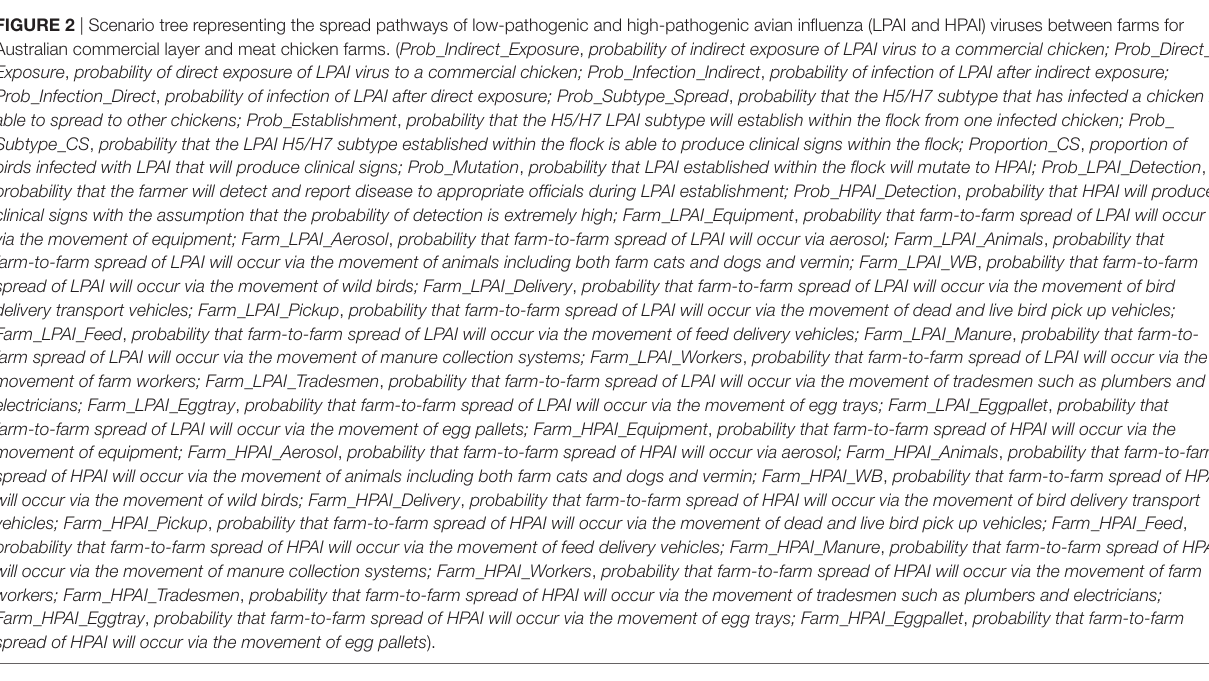
FigUre 2 | Scenario tree representing the spread pathways of low-pathogenic and high-pathogenic avian influenza (LPAI and HPAI) viruses between farms for Australian commercial layer and meat chicken farms. ( Prob_Indirect_Exposure , probability of indirect exposure of LPAI virus to a commercial chicken; Prob_Direct_ Exposure , probability of direct exposure of LPAI virus to a commercial chicken; Prob_Infection_Indirect , probability of infection of LPAI after indirect exposure; Prob_Infection_Direct , probability of infection of LPAI after direct exposure; Prob_Subtype_Spread , probability that the H5/H7 subtype that has infected a chicken is able to spread to other chickens; Prob_Establishment , probability that the H5/H7 LPAI subtype will establish within the flock from one infected chicken; Prob_ Subtype_CS , probability that the LPAI H5/H7 subtype established within the flock is able to produce clinical signs within the flock; Proportion_CS , proportion of birds infected with LPAI that will produce clinical signs; Prob_Mutation , probability that LPAI established within the flock will mutate to HPAI; Prob_LPAI_Detection , probability that the farmer will detect and report disease to appropriate officials during LPAI establishment; Prob_HPAI_Detection , probability that HPAI will produce clinical signs with the assumption that the probability of detection is extremely high; Farm_LPAI_Equipment , probability that farm-to-farm spread of LPAI will occur via the movement of equipment; Farm_LPAI_Aerosol , probability that farm-to-farm spread of LPAI will occur via aerosol; Farm_LPAI_Animals , probability that farm-to-farm spread of LPAI will occur via the movement of animals including both farm cats and dogs and vermin; Farm_LPAI_WB , probability that farm-to-farm spread of LPAI will occur via the movement of wild birds; Farm_LPAI_Delivery , probability that farm-to-farm spread of LPAI will occur via the movement of bird delivery transport vehicles; Farm_LPAI_Pickup , probability that farm-to-farm spread of LPAI will occur via the movement of dead and live bird pick up vehicles; Farm_LPAI_Feed , probability that farm-to-farm spread of LPAI will occur via the movement of feed delivery vehicles; Farm_LPAI_Manure , probability that farm-to- farm spread of LPAI will occur via the movement of manure collection systems; Farm_LPAI_Workers , probability that farm-to-farm spread of LPAI will occur via the movement of farm workers; Farm_LPAI_Tradesmen , probability that farm-to-farm spread of LPAI will occur via the movement of tradesmen such as plumbers and electricians; Farm_LPAI_Eggtray , probability that farm-to-farm spread of LPAI will occur via the movement of egg trays; Farm_LPAI_Eggpallet , probability that farm-to-farm spread of LPAI will occur via the movement of egg pallets; Farm_HPAI_Equipment , probability that farm-to-farm spread of HPAI will occur via the movement of equipment; Farm_HPAI_Aerosol , probability that farm-to-farm spread of HPAI will occur via aerosol; Farm_HPAI_Animals , probability that farm-to-farm spread of HPAI will occur via the movement of animals including both farm cats and dogs and vermin; Farm_HPAI_WB , probability that farm-to-farm spread of HPAI will occur via the movement of wild birds; Farm_HPAI_Delivery , probability that farm-to-farm spread of HPAI will occur via the movement of bird delivery transport vehicles; Farm_HPAI_Pickup , probability that farm-to-farm spread of HPAI will occur via the movement of dead and live bird pick up vehicles; Farm_HPAI_Feed , probability that farm-to-farm spread of HPAI will occur via the movement of feed delivery vehicles; Farm_HPAI_Manure , probability that farm-to-farm spread of HPAI will occur via the movement of manure collection systems; Farm_HPAI_Workers , probability that farm-to-farm spread of HPAI will occur via the movement of farm workers; Farm_HPAI_Tradesmen , probability that farm-to-farm spread of HPAI will occur via the movement of tradesmen such as plumbers and electricians; Farm_HPAI_Eggtray , probability that farm-to-farm spread of HPAI will occur via the movement of egg trays; Farm_HPAI_Eggpallet , probability that farm-to-farm spread of HPAI will occur via the movement of egg pallets